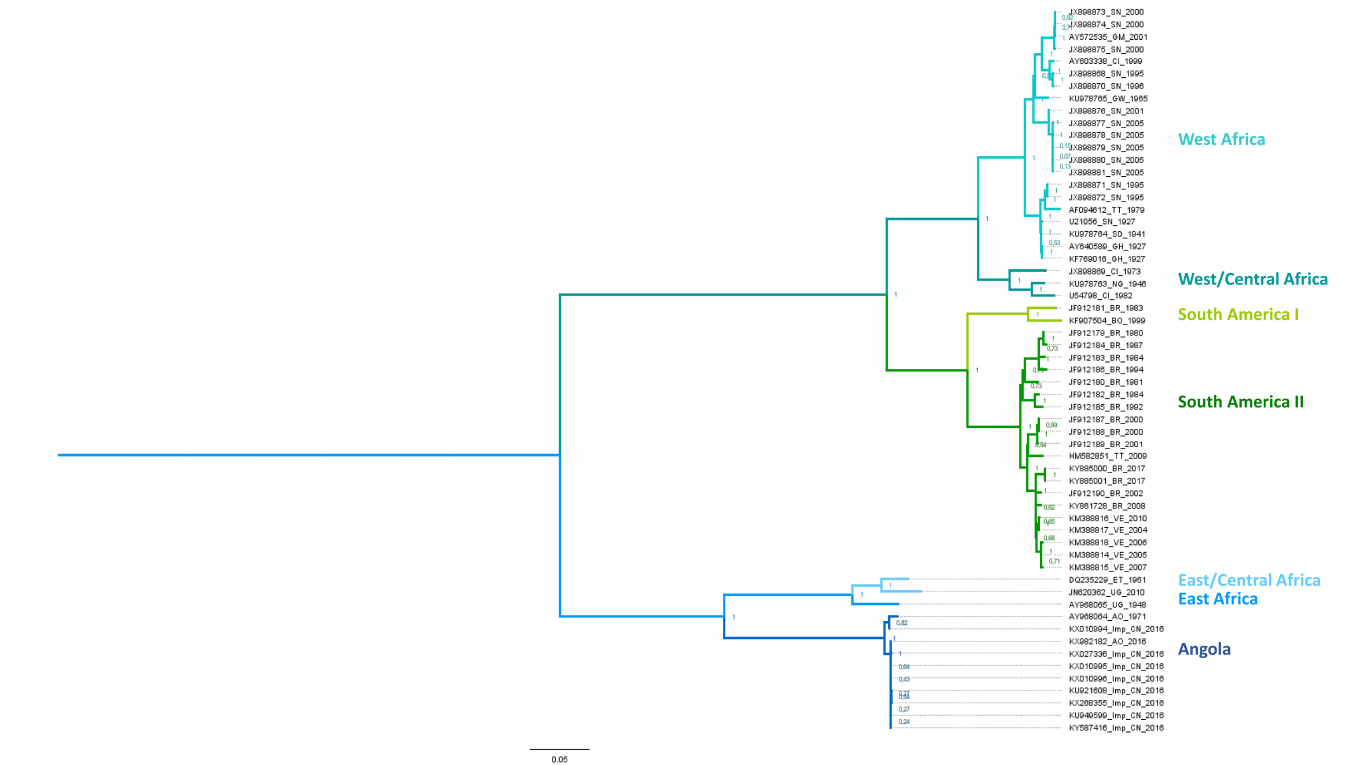
Figure 3. Phylogenetic relationships among strains of YFV. The tree was inferred from an alignment of 59 YFV coding sequence (CDS) downloaded from the European Molecular Biology Laboratory (EMBL) database and aligned according to amino acid sequences using clustalW as implemented in MEGA 7.0 software, v.7.0.26. Phylogenetic reconstruction was done using a maximum-likelihood (ML) method (General Time Reversible Model with a discrete gamma distribution of rates across sites (5 categories (+G, parameter = 0.8110)) and invariant sites ([+I], 24.06% sites)) and bootstrap resampling with 1000 replicates on MEGA 7.0 software. The tree with the highest log likelihood ( − 69934.65) is shown. Initial tree(s) for the heuristic search were obtained automatically by applying Neighbor-Join and BioNJ algorithms to a matrix of pairwise distances estimated using the Maximum Composite Likelihood (MCL) approach, and then selecting the topology with superior log likelihood value. The tree is drawn to scale, with branch lengths measured in the number of substitutions per site. The percentage of trees in which the associated taxa clustered together is shown next to the branches. Sepik virus (Genbank accession number: NC008719) was used as an